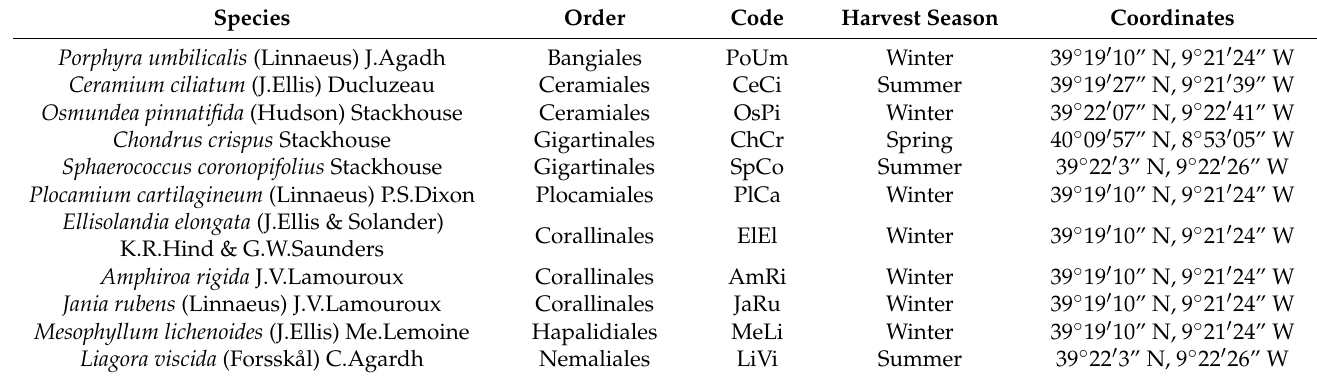
Table 1. List of the species presently studied, corresponding code names and harvesting season. Species Order Code Harvest Season